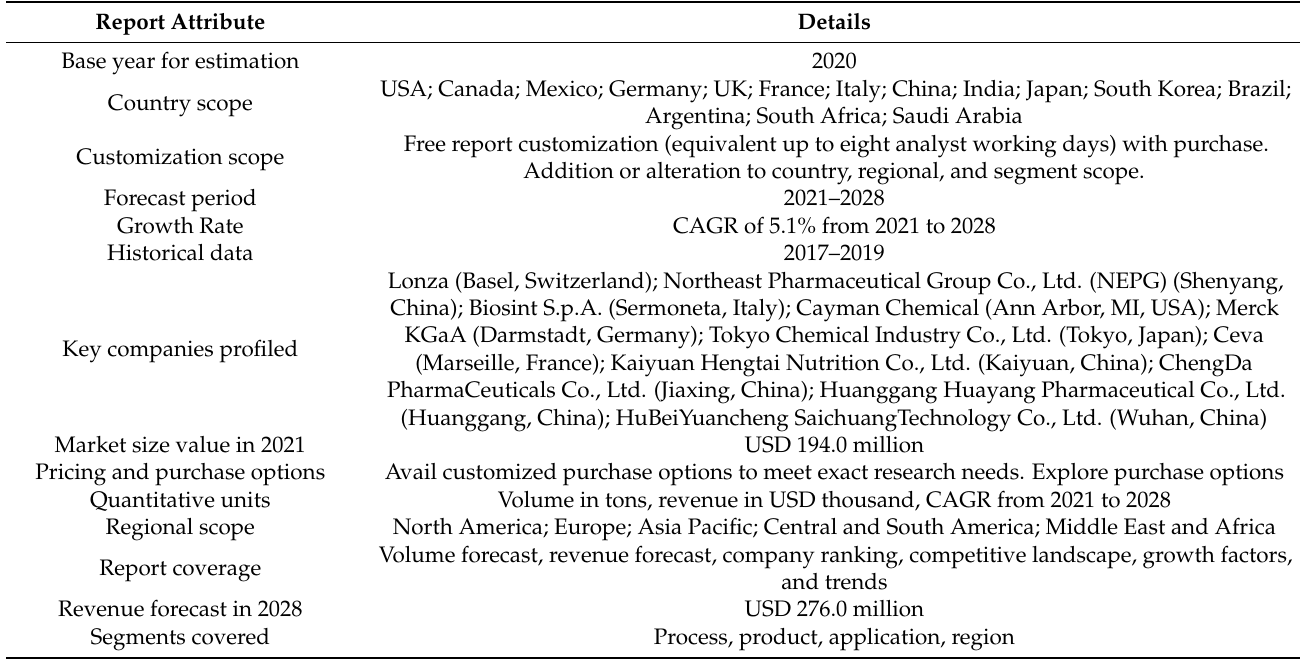
Table 1. Scope of L-carnitine, market research, and regional